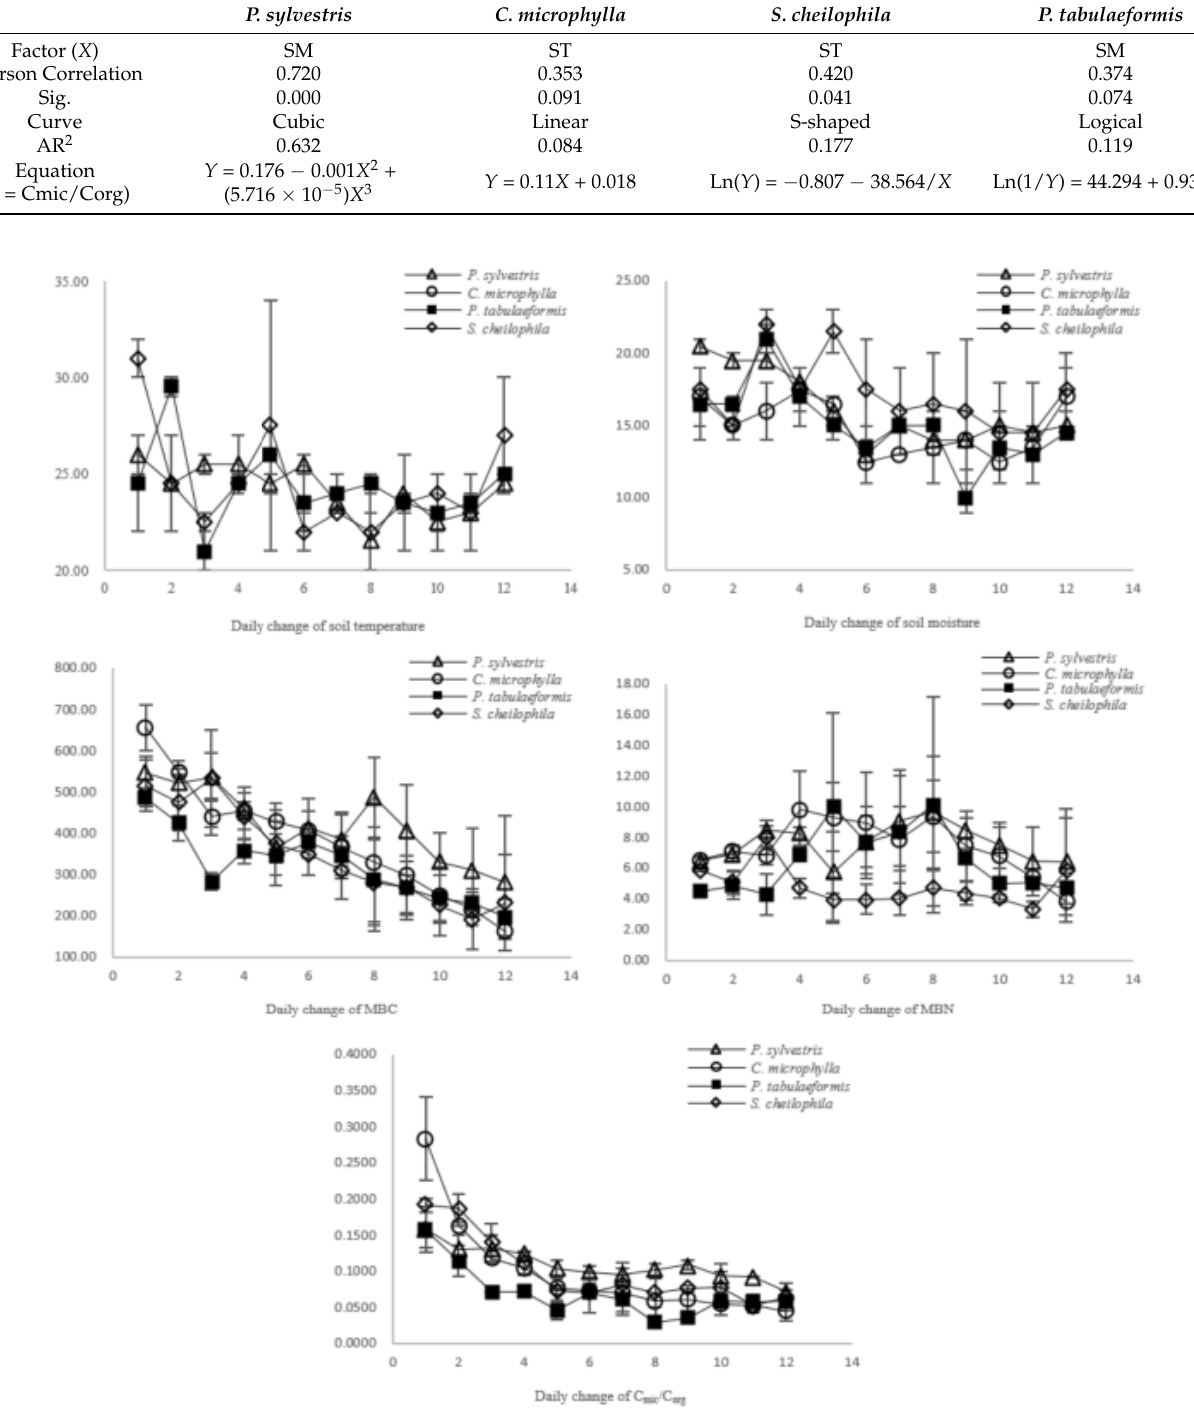
Figure 2. Changes in soil temperature (°C) soil moisture (%), microbial biomass carbon (mg/kg), microbial biomass nitrogen (mg/kg), and the microbial quotient (Cmic/Corg). It is difficult to simultaneously monitor the SM and ST of many plots in the field, so we used the atmospheric temperature (AT) and time after cessation of the water input (interval days, ID). The ST could be calculated based on the average ST/AT ratio during the sampling days of different vegetation types ( P. sylvestris = 1.01, C. microphylla = 1.05,